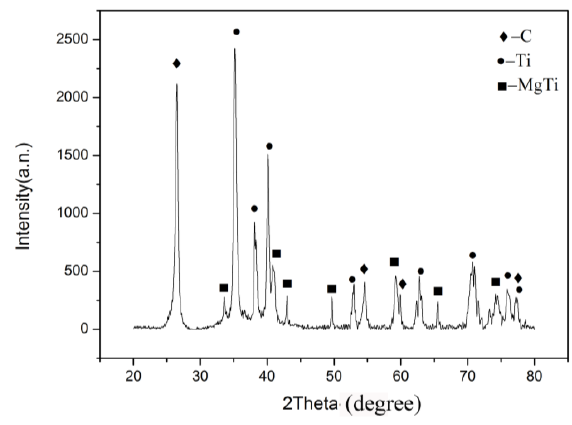
Figure 3. The XRD spectrum of the composites with 1.0 wt.% CNTs.